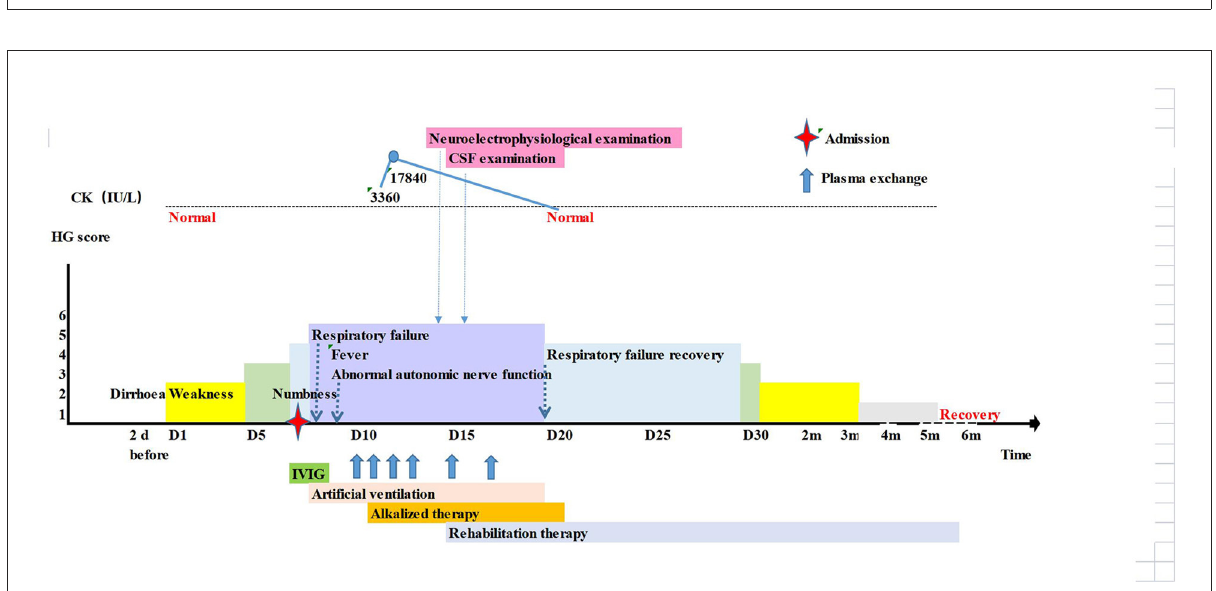
FIGURE2 Timeline of the patient 2’s clinical manifestations, laboratory examinations and treatments.